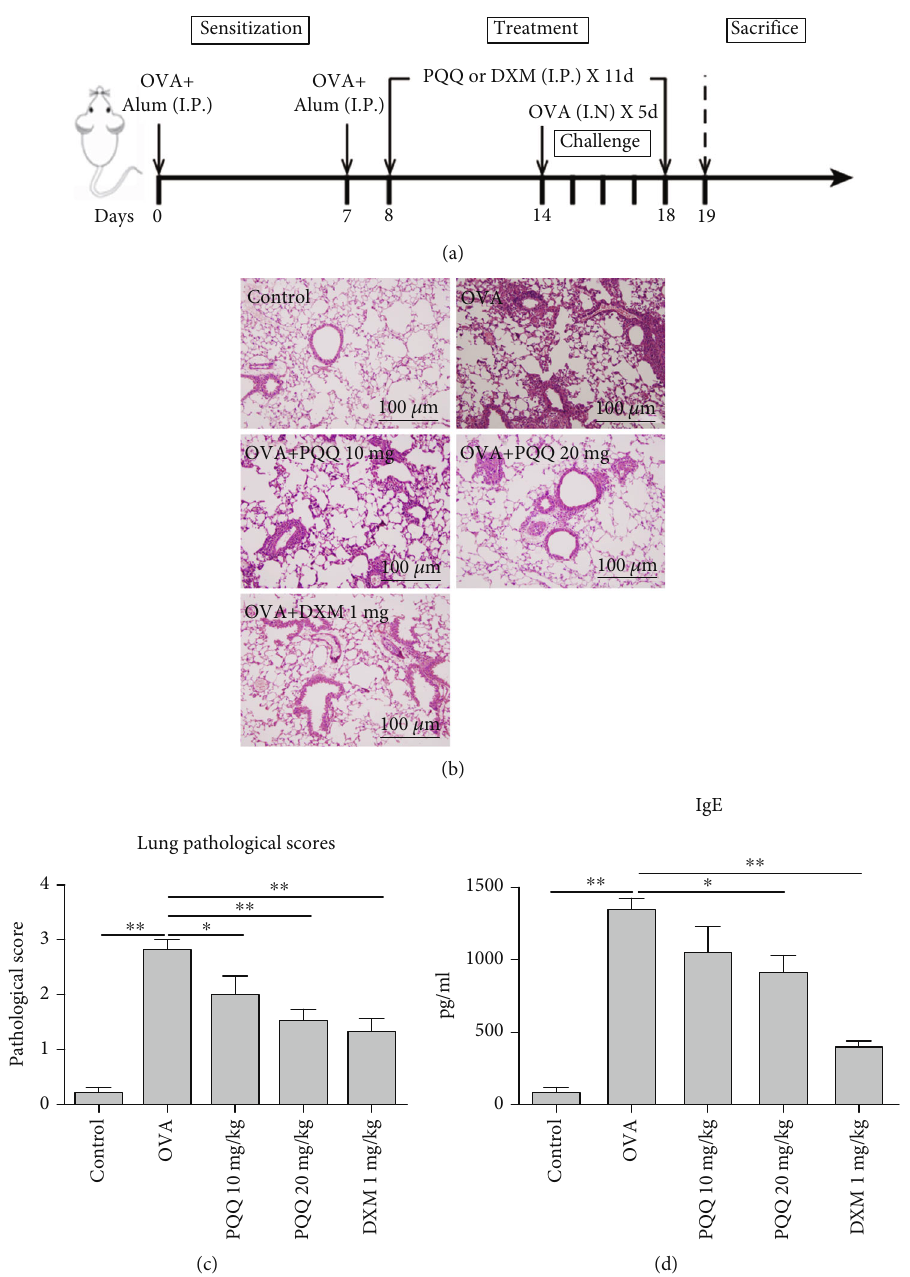
Figure 3: PQQ administration attenuates airway in fl ammation in an OVA-induced mouse model. (a) Protocols for establishment of the OVA-induced allergic asthma mouse model and administration of PQQ. (b) Representative photomicrographs of lung sections stained with H&E and examined at 100x magni fi cation. (c) Lung pathological scores of peribronchial and perivascular in fl ammatory cell in fi ltration in asthmatic model mice and PQQ-/DXM-treated asthmatic model mice. (d) Serum IgE levels in asthmatic model mice and PQQ-/DXM-treated asthmatic model mice. The columns and error bars represent the means and SEMs ( n = 5 per group). ∗ P < 0 : 05 , ∗∗ P < 0 : 01 . Similar results were obtained in at least three independent